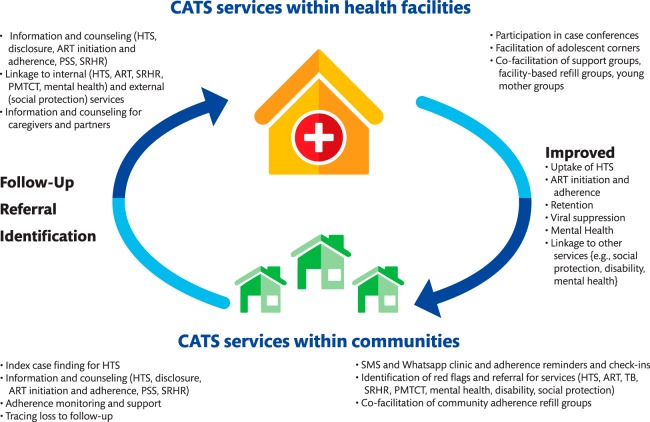
The Zvandiri Model of Care Involving the Community Adolescent Treatment Supporters in ZimbabweAbbreviations: ART, antiretroviral therapy; CATS, community adolescent treatment supporters; HTS, HIV testing services; PLHIV, people living with HIV; PMTCT, prevention of mother-to-child transmission of HIV; PSS, psychosocial support; SRHR, sexual and reproductive health and rights; SMS, short message service; TB, tuberculosis.